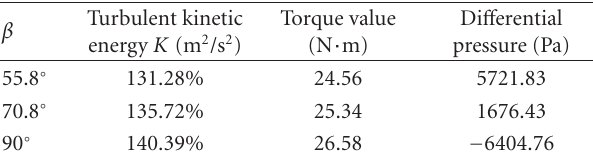
Table 2: Targeted values with di ff erent blade laying angles.